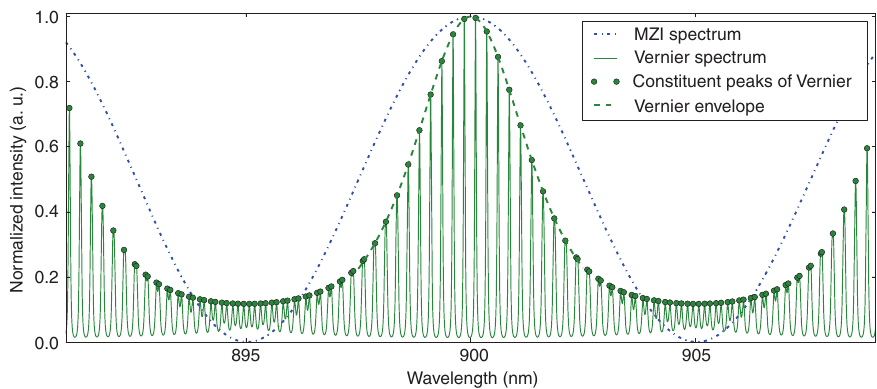
Figure 2: Spectra of a Vernier sensor and Mach-Zehnder interferometer, where the respective arms of the latter have the same length as the ring roundtrip of the